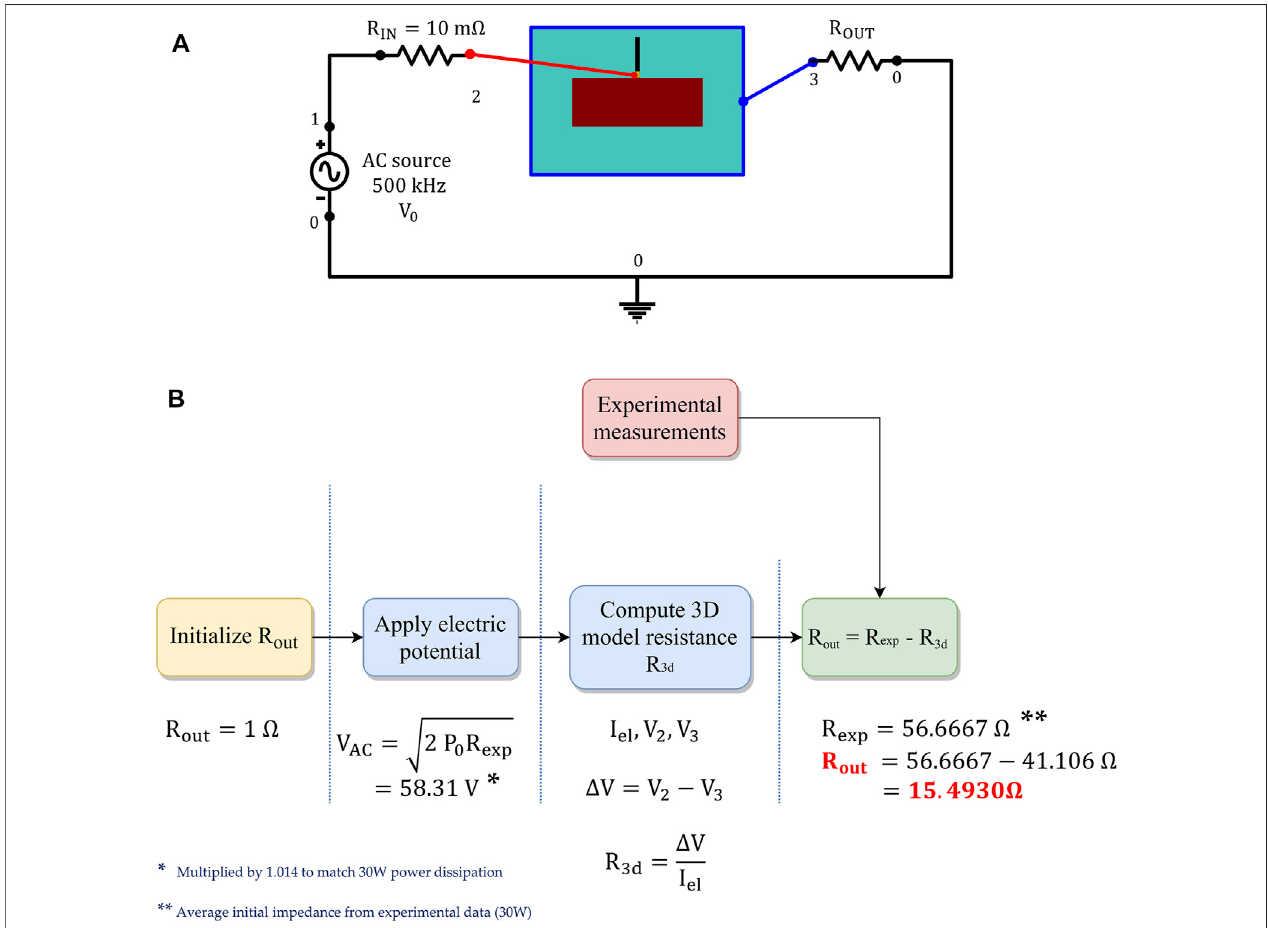
FIGURE 3 | (A) External 0D electrical circuit coupled to the 3D computational model, to apply the RF stimulus. (B) Procedure employed to calibrate the output resistance R out , matching the experimentally measured